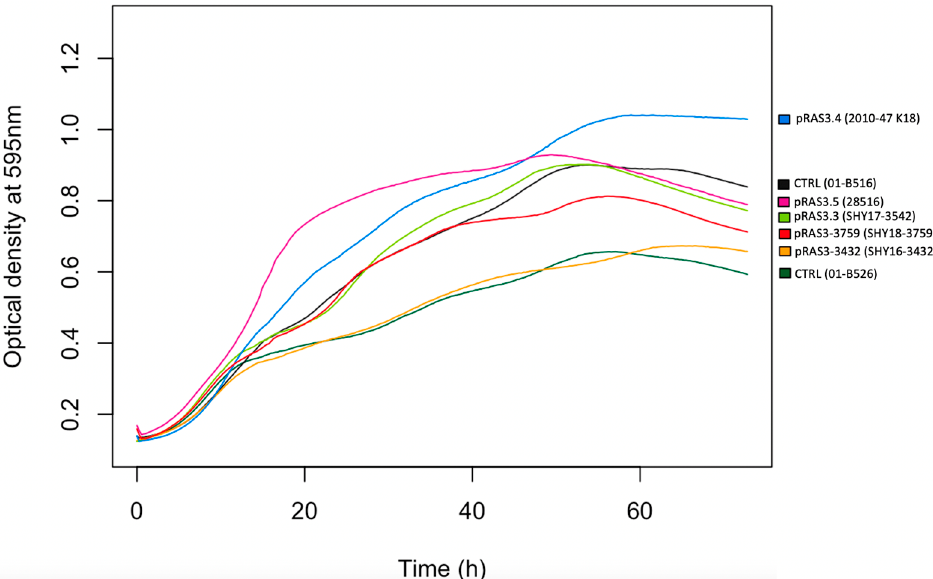
Figure 4. Growth curves at 18 °C of the various pRAS3 plasmids in their strains of A salmonicida subsp. salmonicida . Two control strains that do not contain pRAS3 were tested. The name of the strains used for the experiment are indicated for each of the curves shown. The strains are shown in Table 1.